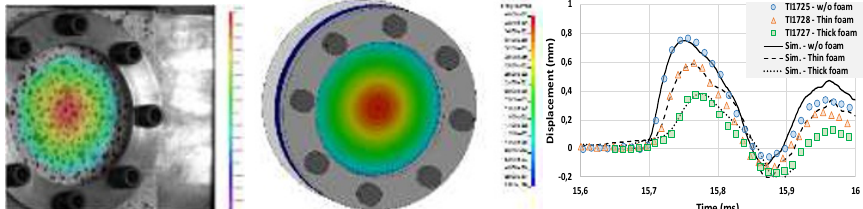
Fig. 3. Example of measured and calculated back face deformation